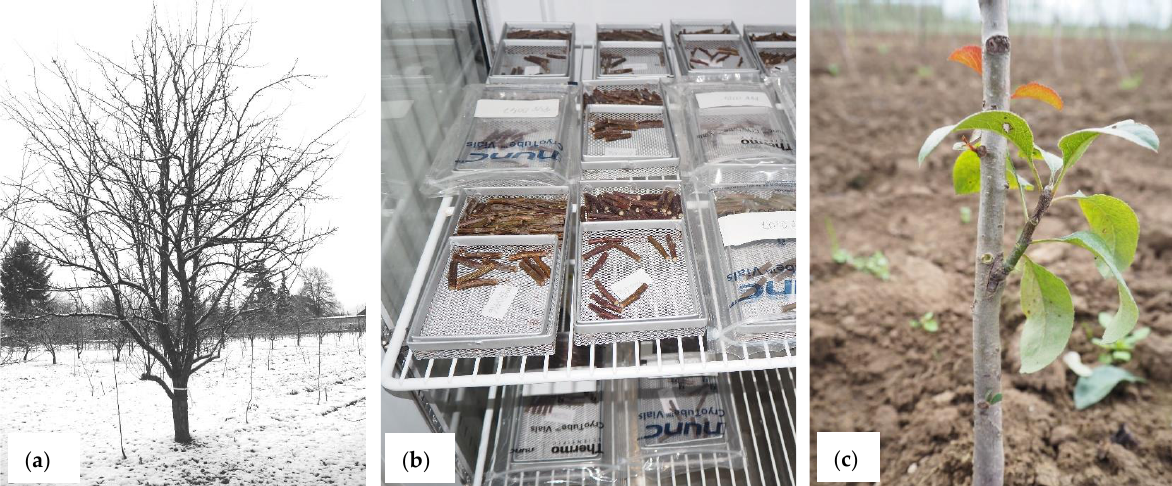
Figure 1. Cryopreservation of dormant Pyrus buds: ( a ) Trees of P. pyraster during winter-time in January; ( b ) Single bud sections during the dehydration step at a temperature of – 5 °C; ( c ) Recovery of P. elaeagrifolia buds after cryopreservation in the orchard.